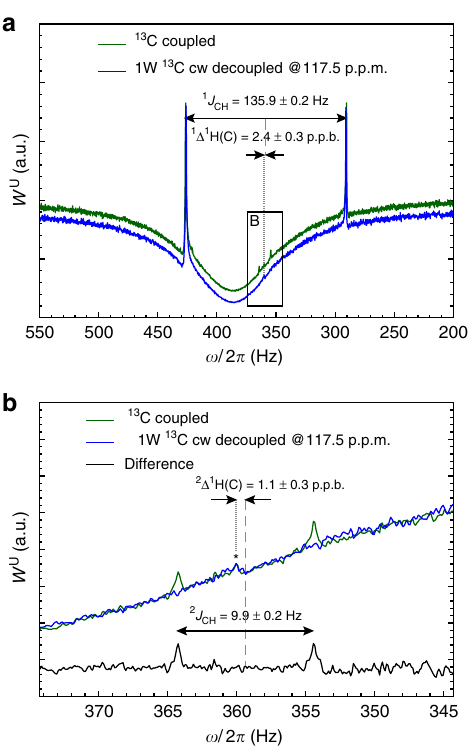
Figure 3 | Experimental measurements of isotope satellites. Experimental 700MHz 1 H spin-noise spectra at SNTO condition of 90% (v/v) acetonitrile with 10% (v/v) DMSO-d 6 for field frequency locking. ( a ) CH 3 - region including the primary and secondary satellite doublets (green curve). The blue trace shows the selectively 13 CN decoupled spectrum, slightly shifted downwards for better visibility. ( b ) The enlarged traces within the rectangle in a displayed together with their difference (black trace). The small peak between the satellites highlighted by an asterisk results from the interference between the residual magnetic field inhomogeneity and the radiation-damped main peak. It corresponds to the exact chemical shift of the 12 C-methyl protons.